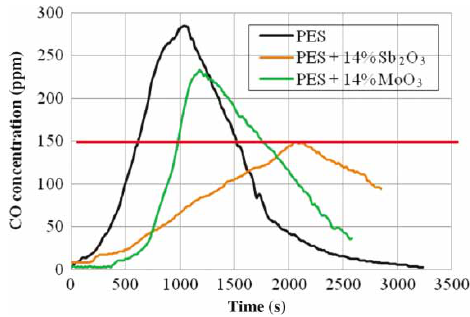
Fig. 13. CO concentration time series registered by B2 sensor located at the centre of the compartment (post B) at 2.7 m for three studied samples